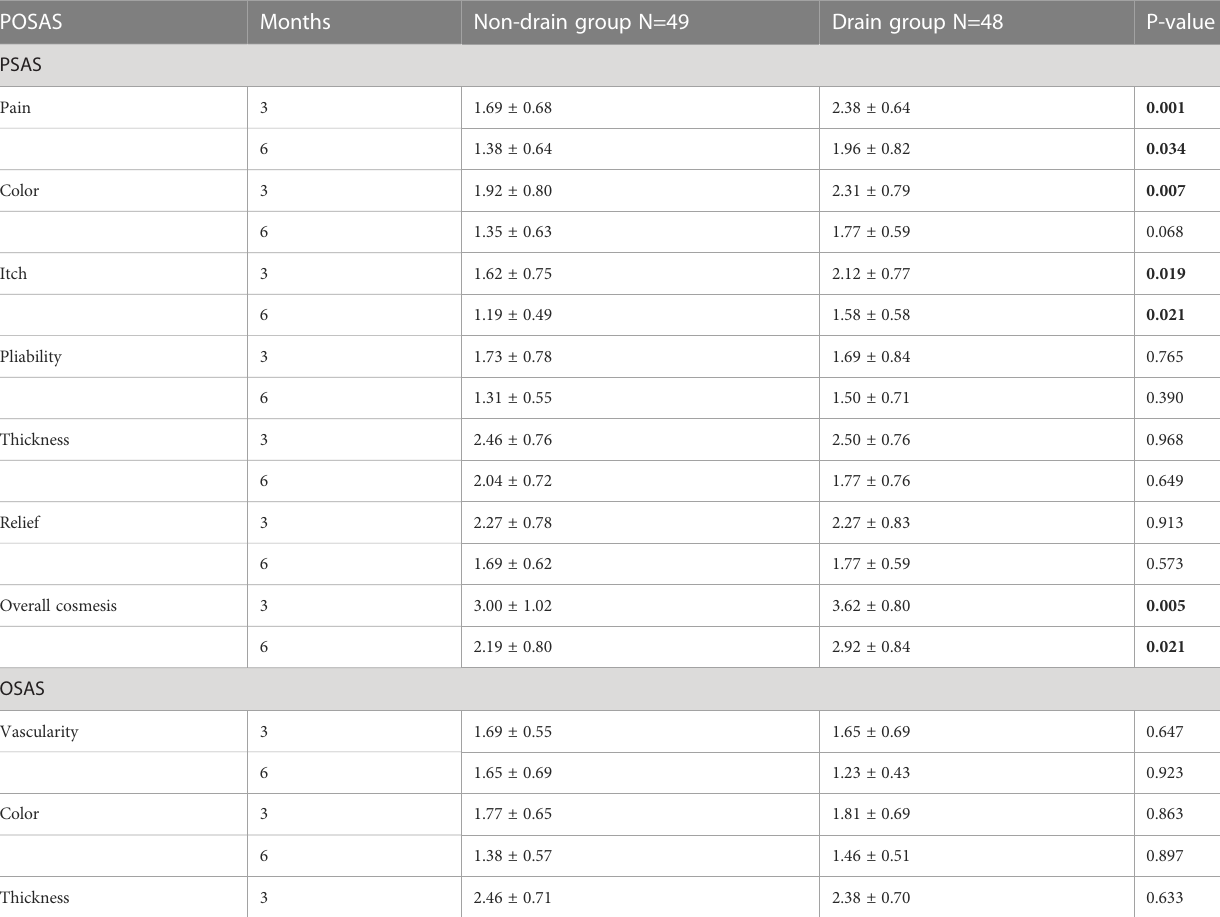
TABLE 6 Comparison of POSAS between the non-drainage group and drainage